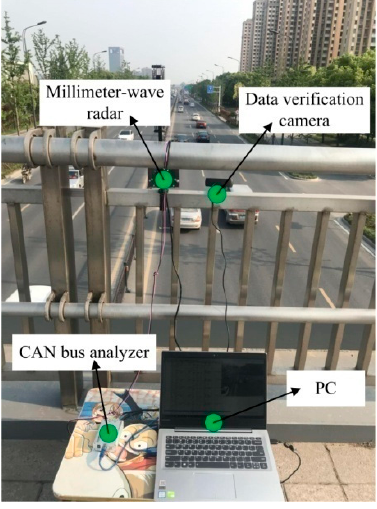
Figure 1. Experimental scenario. CAN: controller area network. Table 2. Parameters of the installation and the road section.